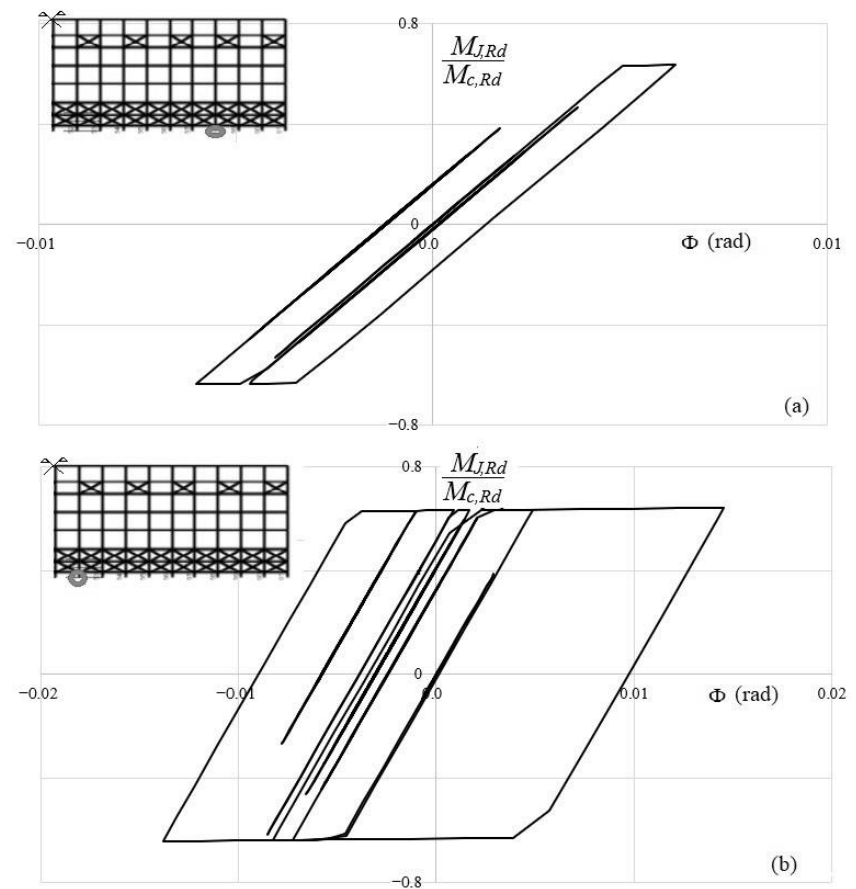
Figure 13. Zoom on cyclic behavior of base-plate connections, Zone_2 with α g = 1.0: ( a ) far and ( b ) near to the center of the rack. Table 6. Cross-aisle displacements at 15th level, with NLTH (in mm).